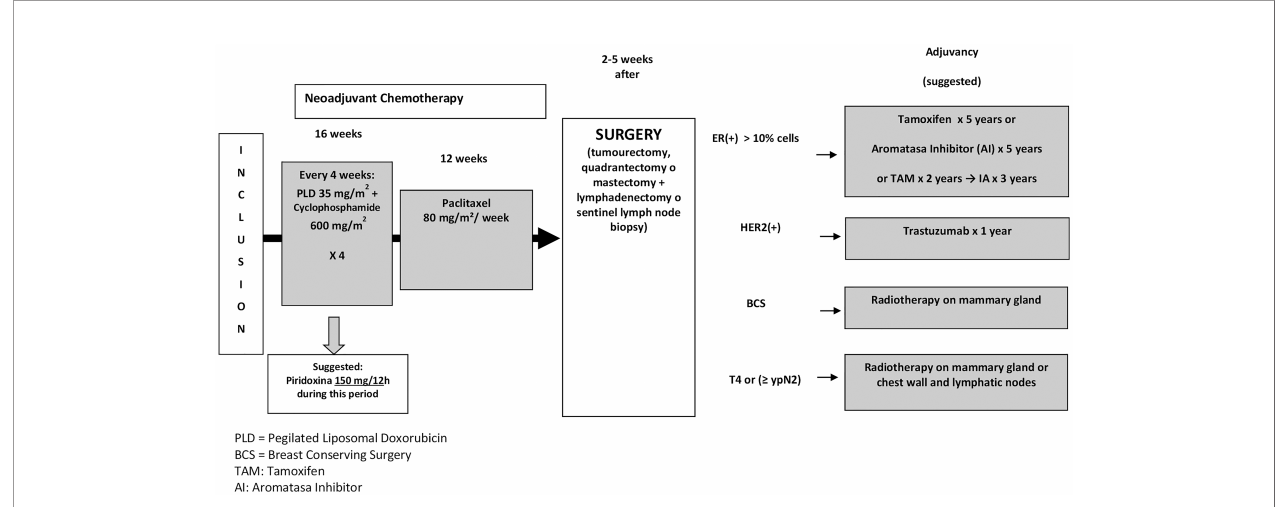
FIGURE 1 | Scheme of the Study. PLD, Pegylated liposomal doxorubicin; ER, Estrogen receptors; HER2, Human epidermal growth factor receptor 2; BCS, Breast conservative surgery; TAM, Tamoxifen; N, Node; IA, Aromatase